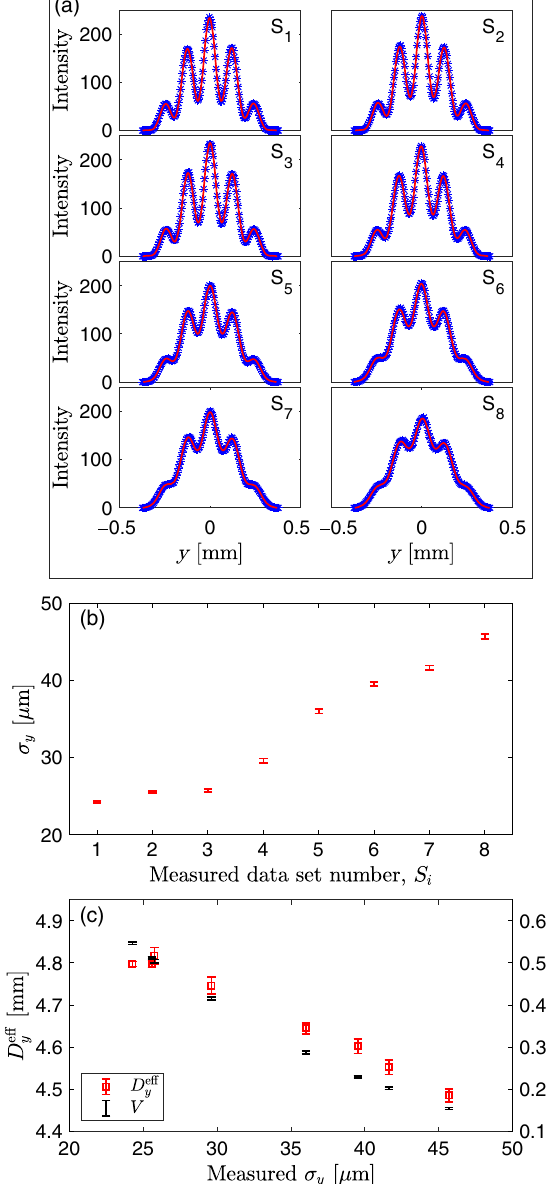
FIG. 9. Beam size measurements with a varying vertical size using setups of the storage ring lattices with different emittance coupling. (a) For each of the eight sets of measurements, a representative intensity distribution (blue stars) and fitting curve (red lines) are shown, selected from one of the ten images. (b) The measured beam size with the statistical error based on ten images for each set of measurements. (c) The effective slit separation and measured visibility versus the measured beam size. All the measurements are performed with a single beam operated at 562 MeV with a current of about 10